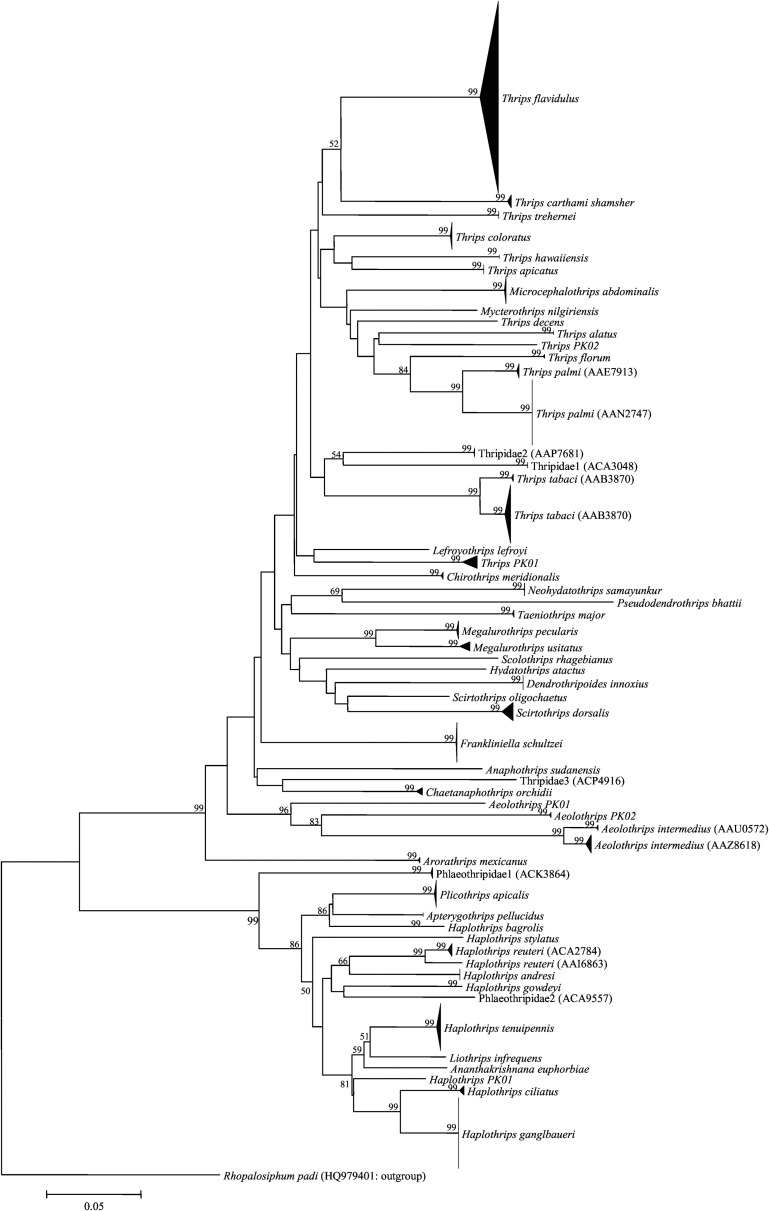
NJ analysis of COI-5′ sequences from species of thrips from Pakistan.Bootstrap values (%) (500 replicates) are shown above the branches (values <50% are not shown) while the scale bar shows K2P distances. The node for each species with multiple specimens was collapsed to a vertical line or triangle, with the horizontal depth indicating the level of intraspecific divergence. BIN numbers are shown for species with only family-level identification or those split into two BINs.